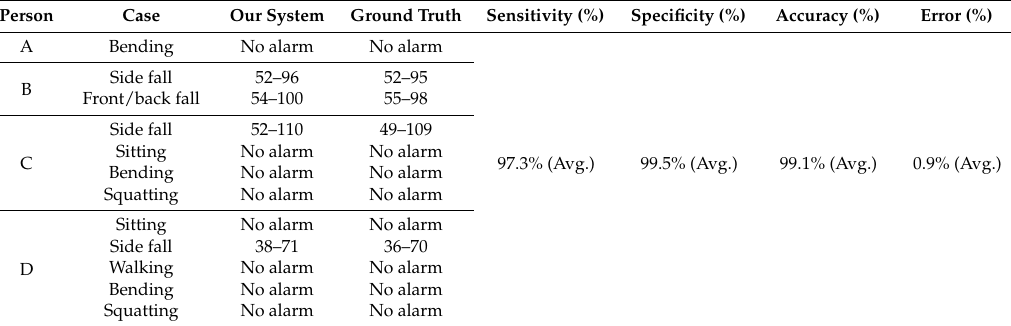
Table 2. Classification result of our system for representative